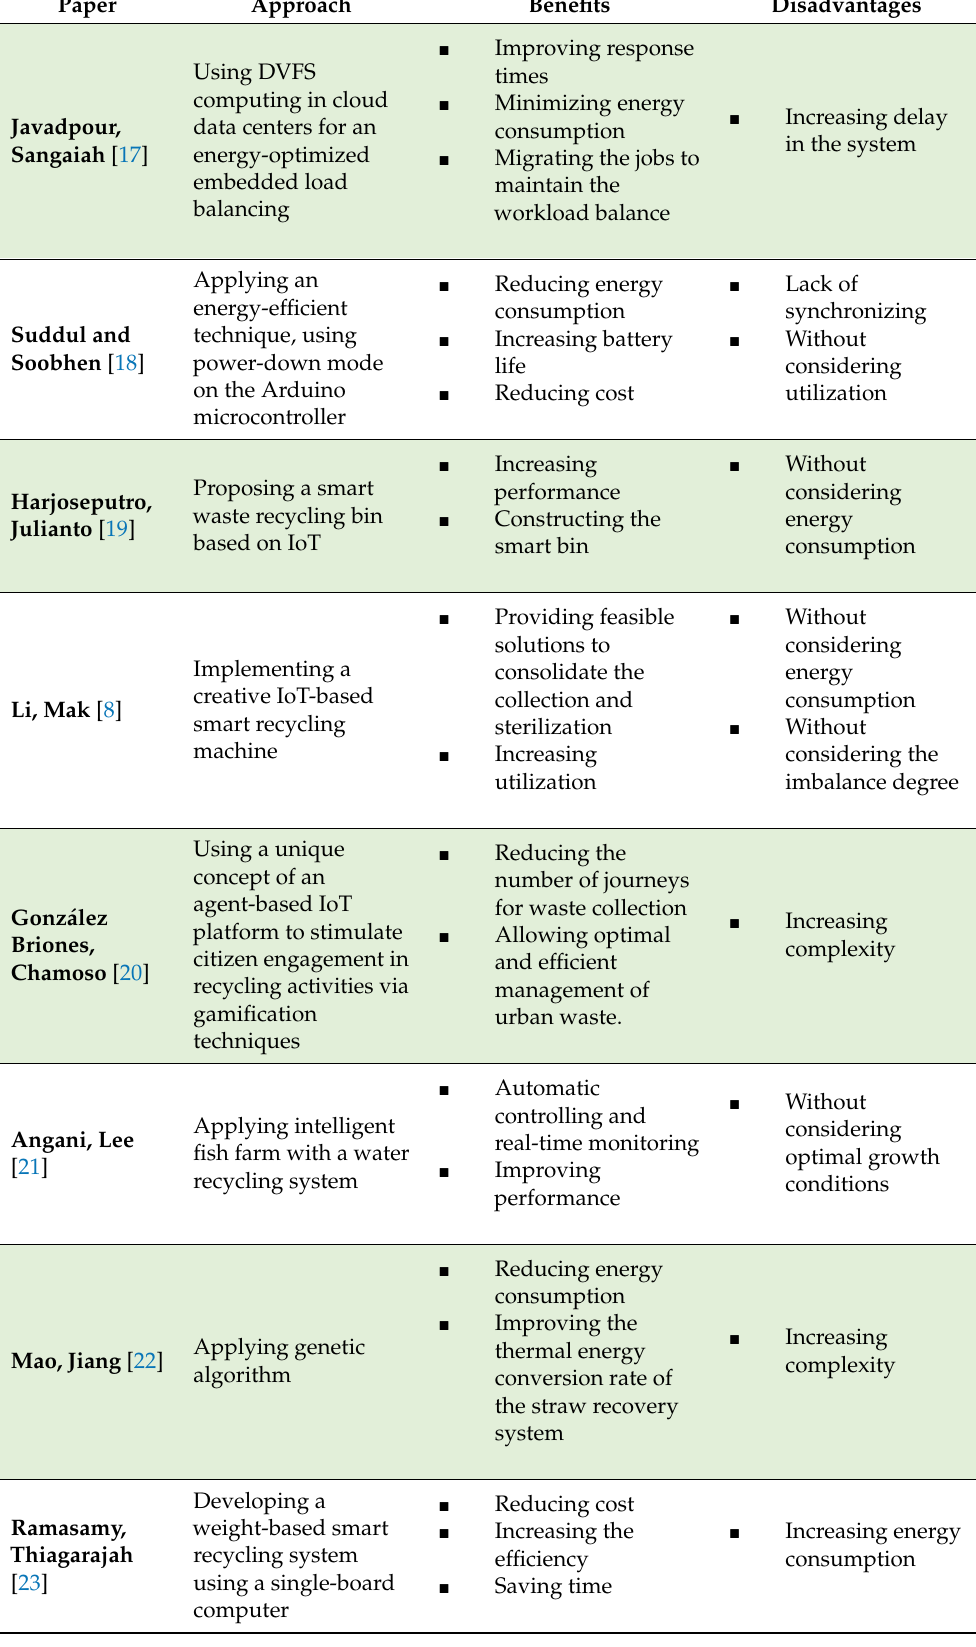
Table 1. Side-by-side comparison of the discussed